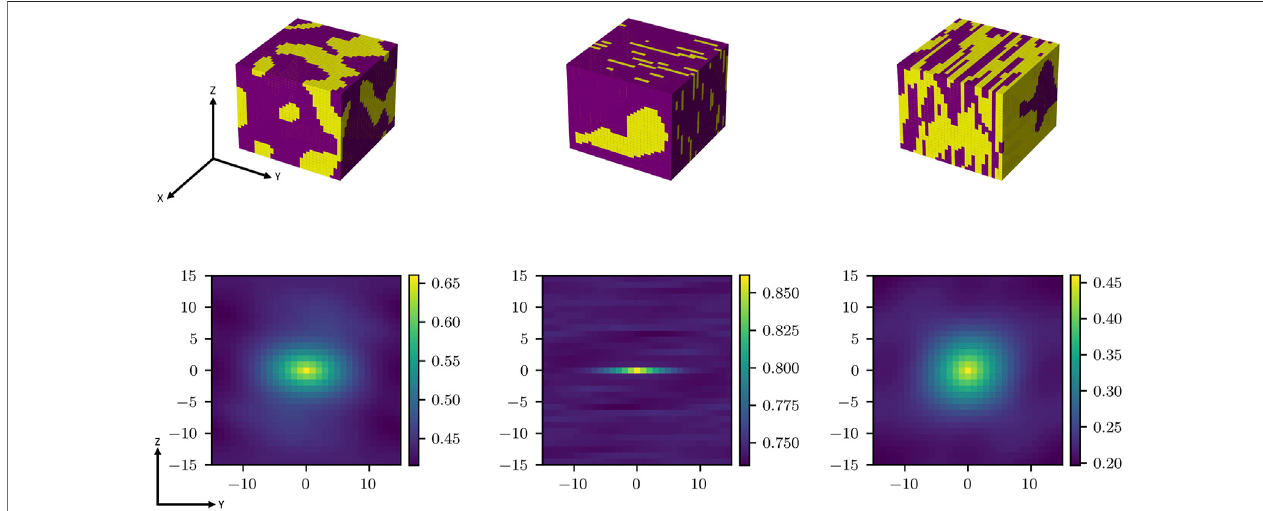
FIGURE 2 | Example 3-D RVEs with the corresponding Y-Z mid-sections of their 2-point spatial correlations. It is seen that the 2-point autocorrelations capture various salient measures of the microstructures (for example, the center peak in these plots re fl ects the phase volume fraction and the shape of the central peak region re fl ects the average shape of the phase